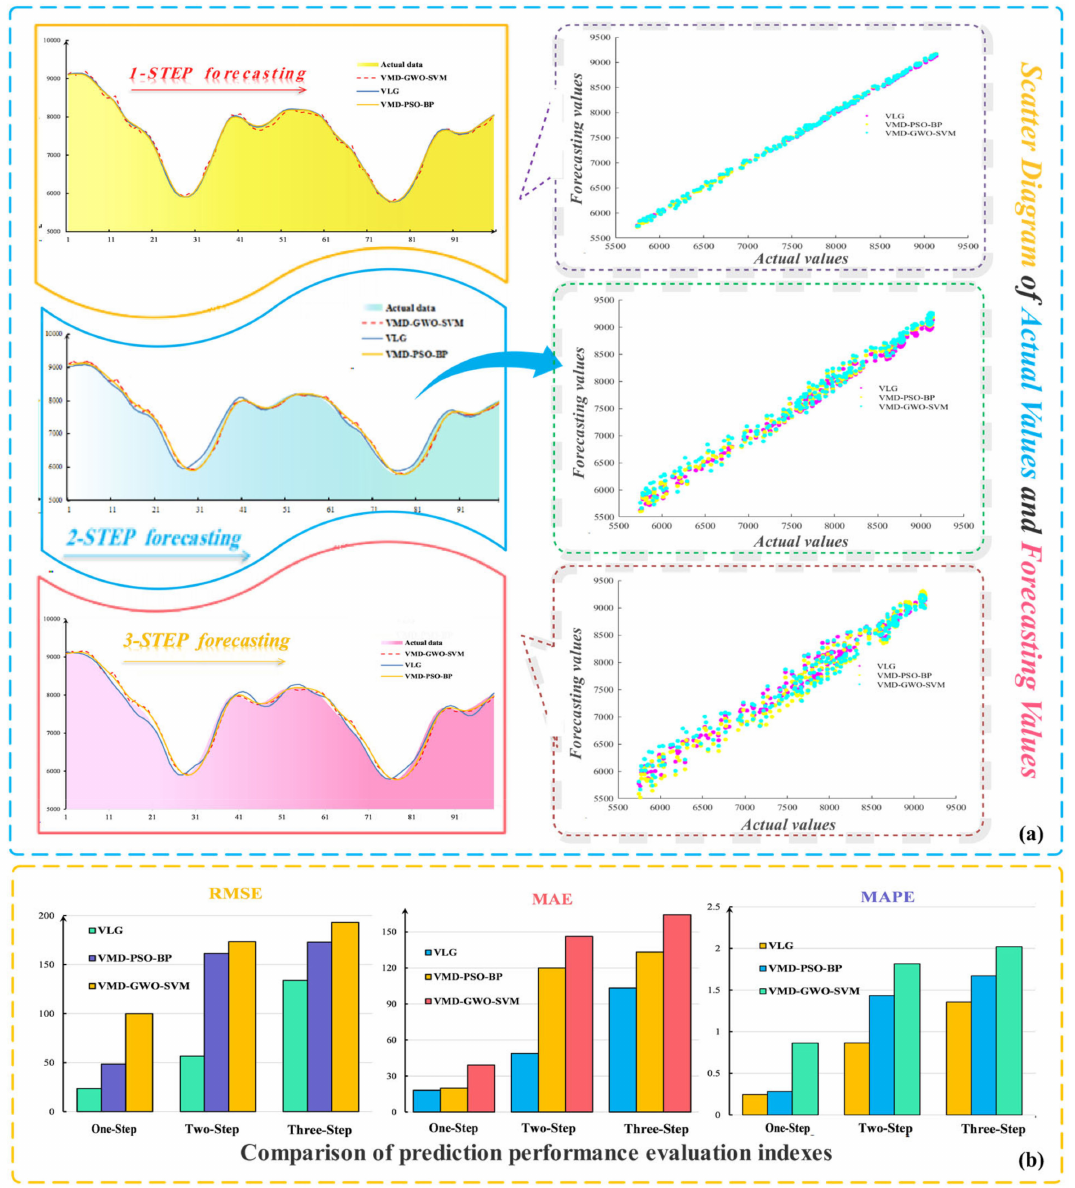
Figure 8. Comparison between the VLG model and the classical hybrid model in multi-step predictions. ( a ) Prediction model fitting. ( b ) Comparison of prediction performance evaluation